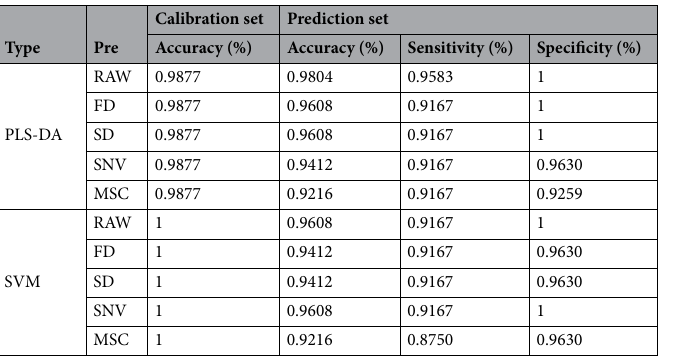
Table 1. Classification results of the PLS-DA and SVM models with different preprocessing